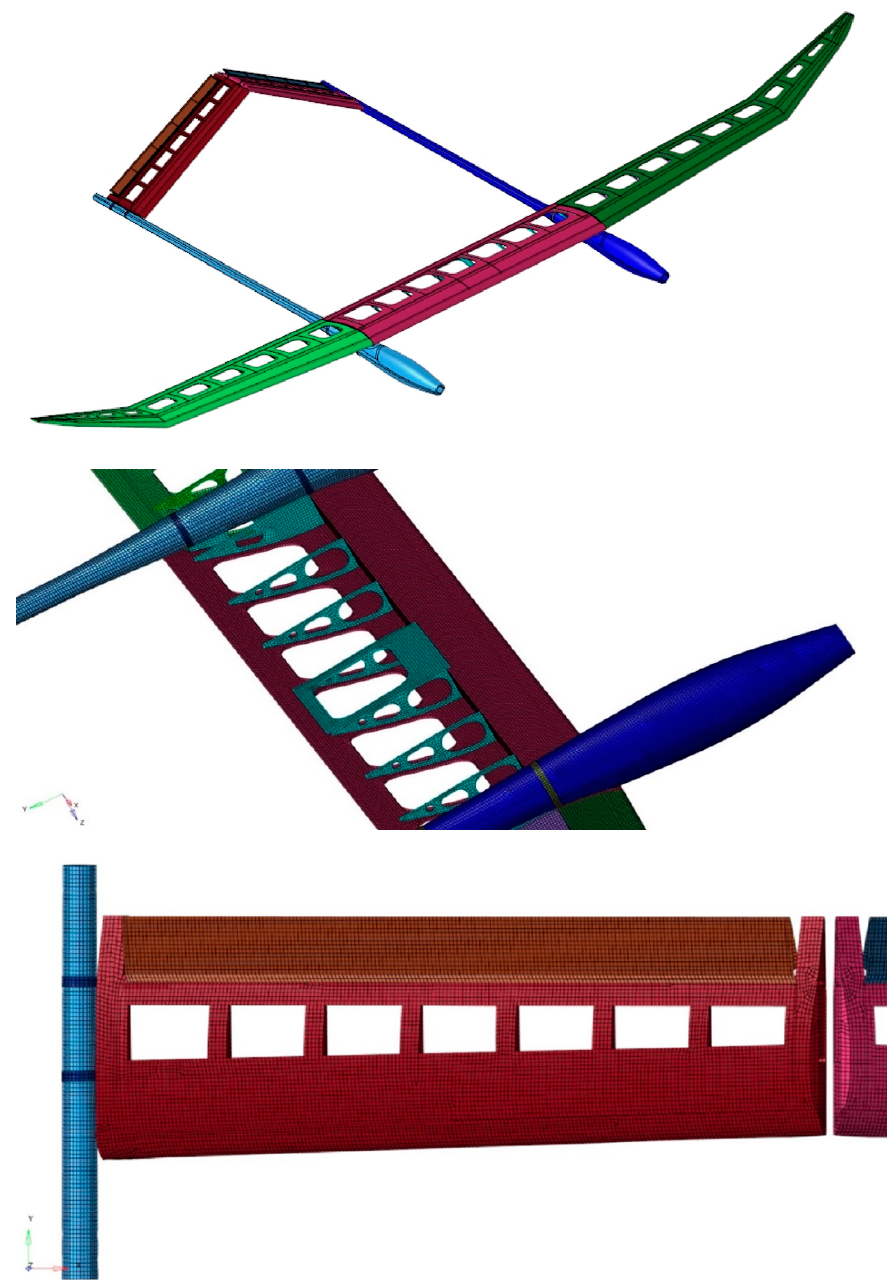
Figure 14. The simplified and discrete model of the STRATOS.